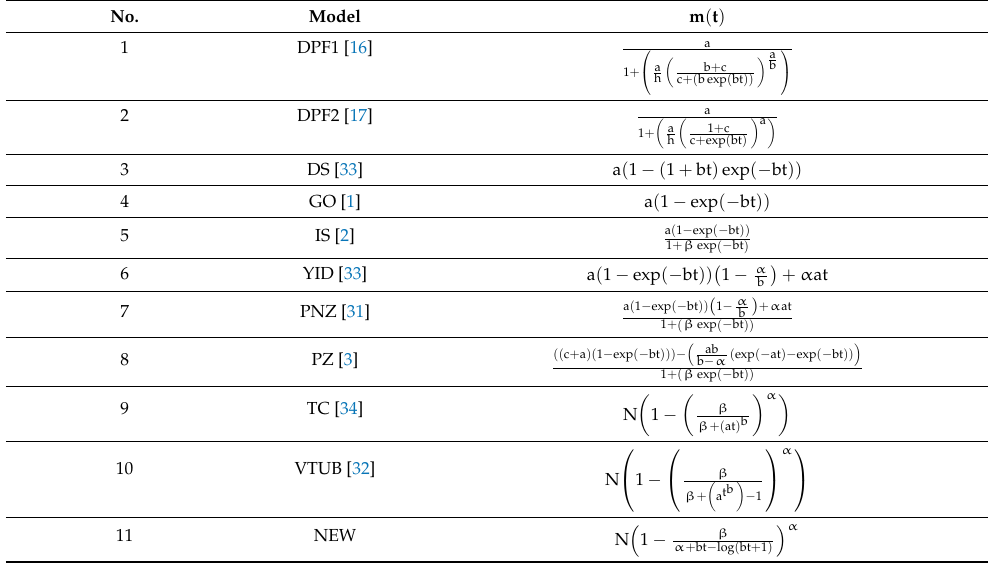
Table 1. Mean value functions for existing NHPP models and the proposed